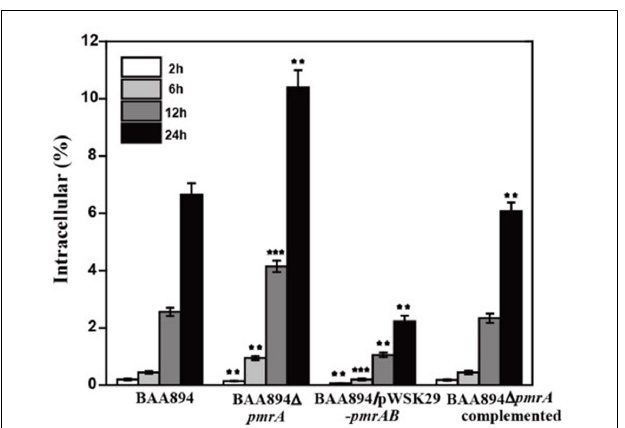
FIGURE 3 | Survival and replication in RAW264.7 macrophages. Results are presented as the percentage of the initial inoculum that was intracellular. The values represent the mean ± SD of results from three independent experiments. The data were analyzed by one-way analysis of variance. Statistically significant differences between the mutants and C. sakazakii wild strain: ** p < 0.01 and *** p < 0.001.